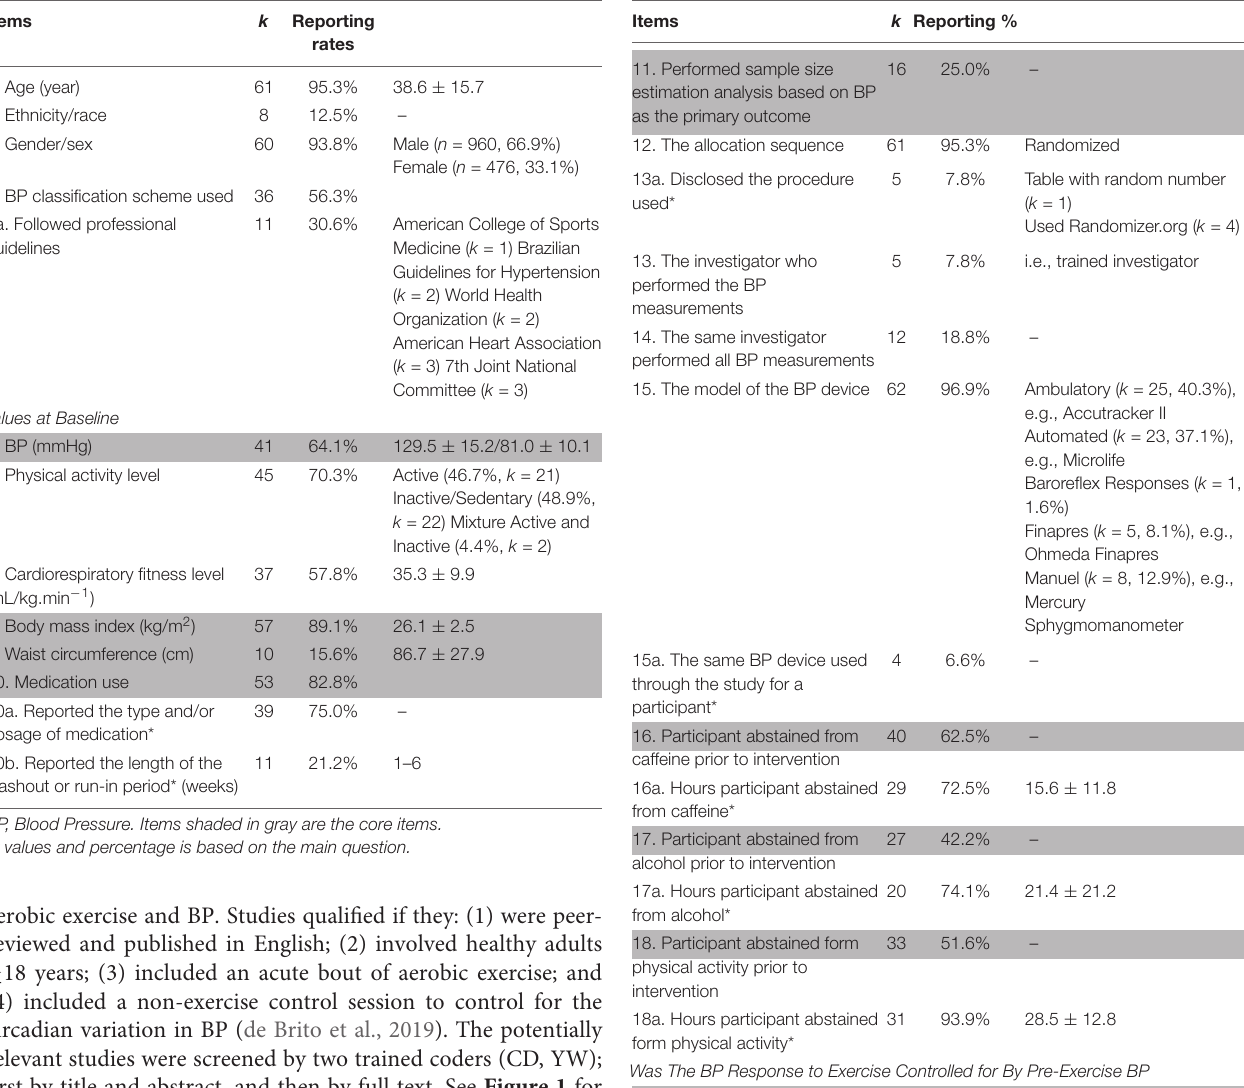
√ list part two study